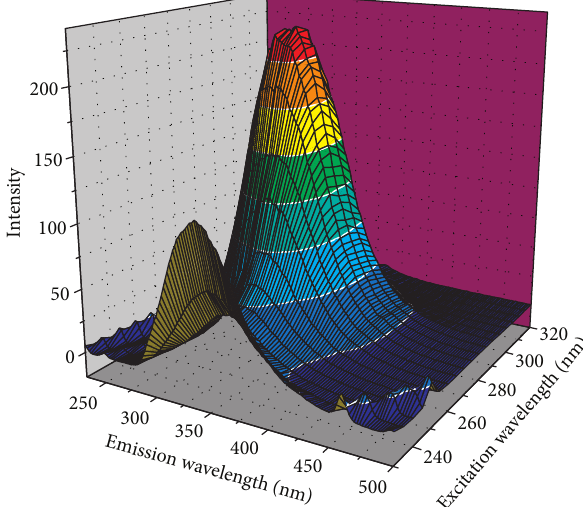
Figure 2: The excitation-emission matrix (EEM) spectrum of a mixture recorded from 230 to 500 nm in the emission domain and from 230 to 320 nm in the excitation